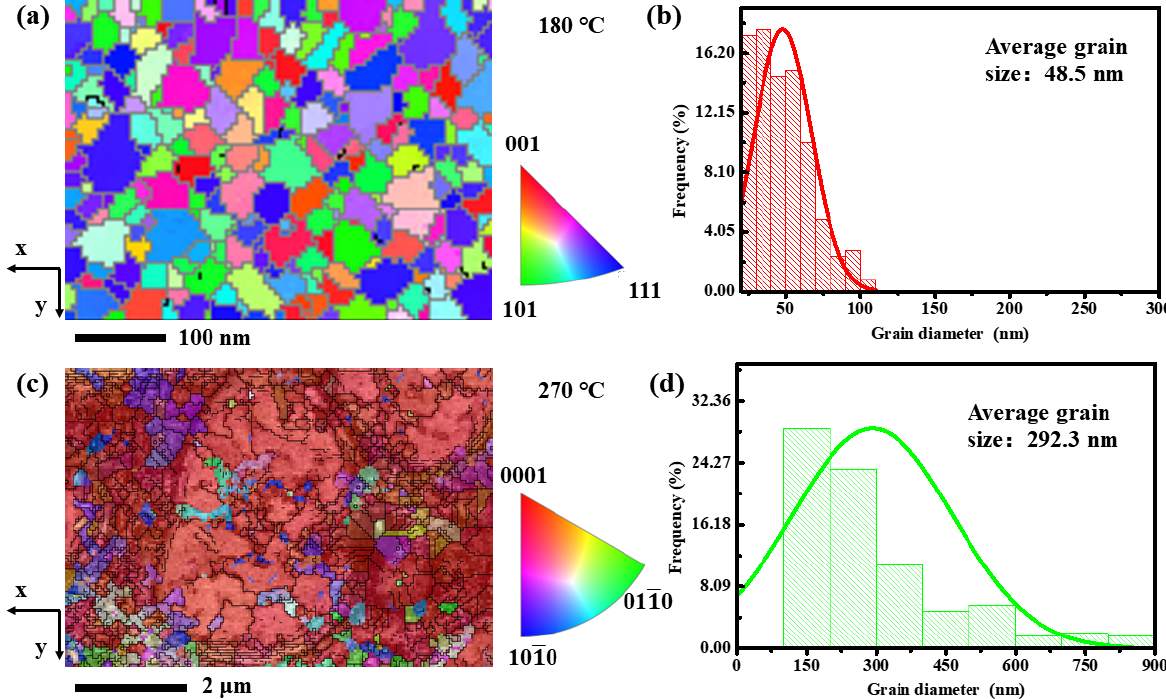
Figure 4. ( a ) and ( b ) are the inverse polar figure (IPF) of the film and the statistical grain size dis- tribution at 180 °C. ( c ) and ( d ) are the IPF of the film and the statistical grain size distribution at 270 °C.